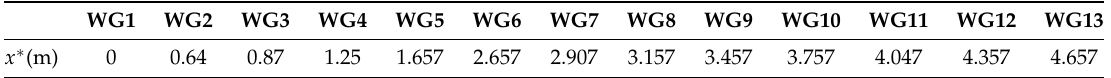
Table 1. WG locations WG1-WG13 in